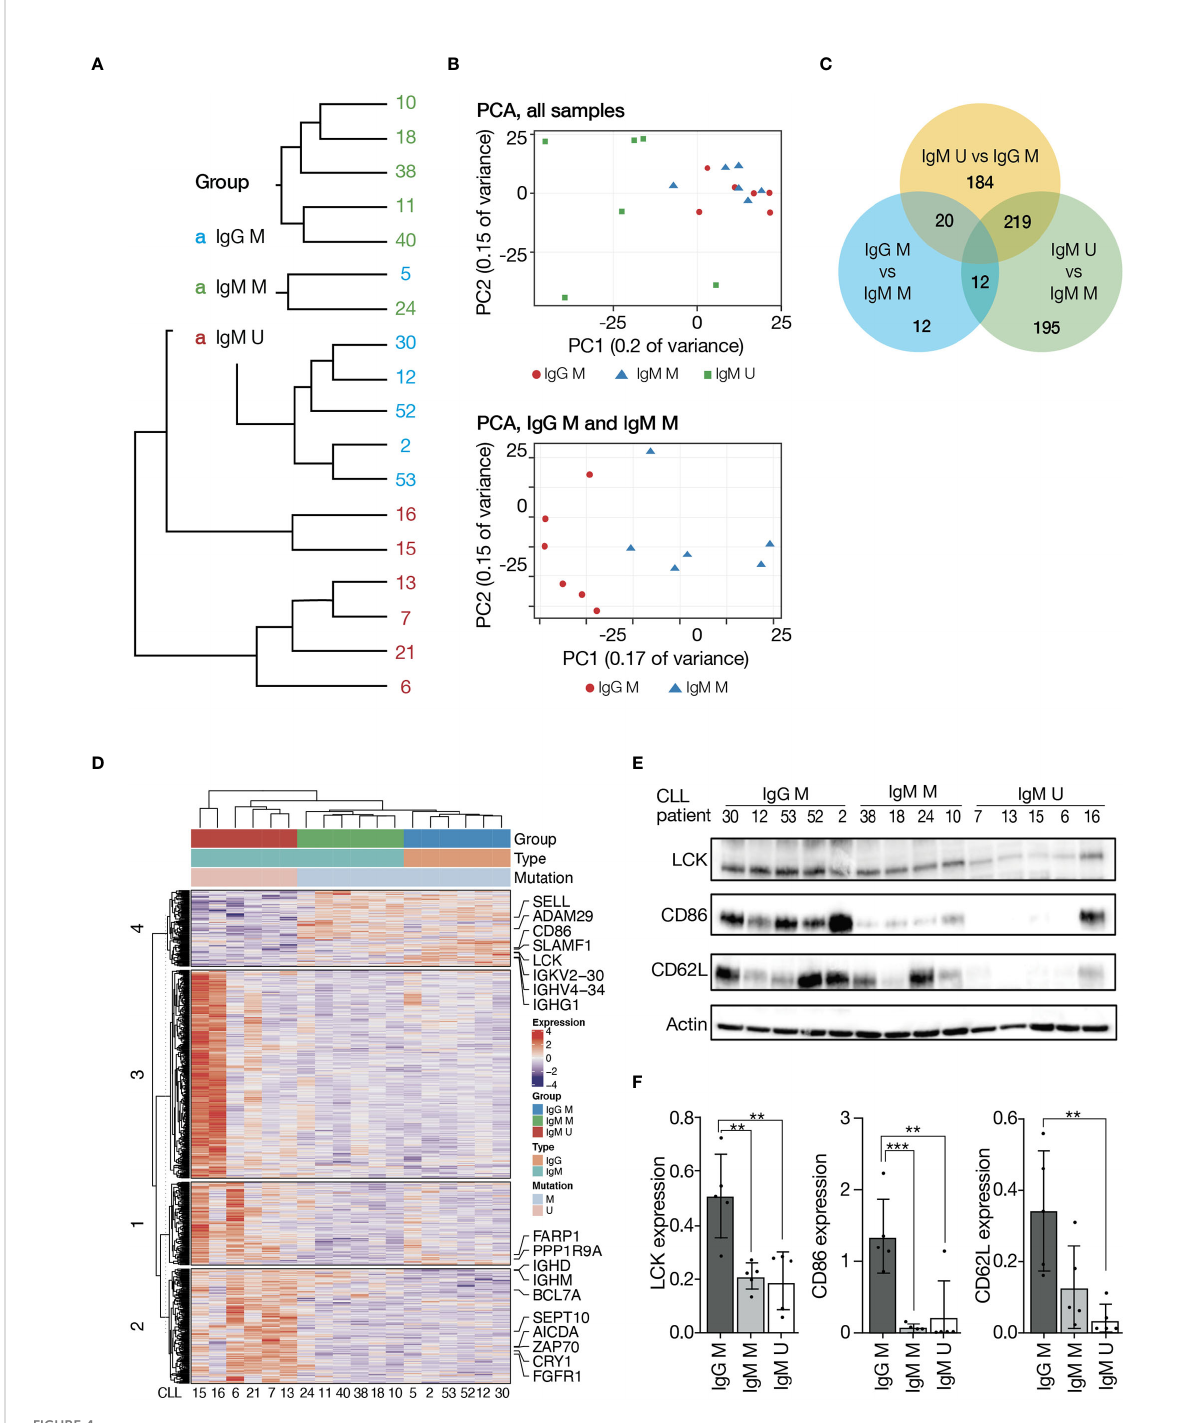
FIGURE 4 Gene expression pro fi ling of CLL immunogenetic subgroups. RNA was extracted from unstimulated CD19 + CLL cells. Sequencing libraries were prepared using INCPM mRNA. (A) Unsupervised hierarchical clustering. (B) Principal component analysis. (C) Venn diagram showing the number of genes differentially expressed between the three subgroups. (D) Heatmap of genes differentially expressed between the three subgroups (>2-fold change, padj ≤ 0.05). Gene expression is median centered and scaled as indicated. (E) Representative Western blot analysis of IgM or IgG M-CLL and IgM U-CLL cells showing LCK, CD86, and CD62L levels. Actin was used to verify equal loading. (F) Quanti fi cation of LCK, CD86, and CD62L levels in IgG M-CLL, IgM M-CLL, and IgM U-CLL cells in (E) by normalization to actin using the myImageAnalysis ™ Software (n = 15). **p < 0.01 and ***p <